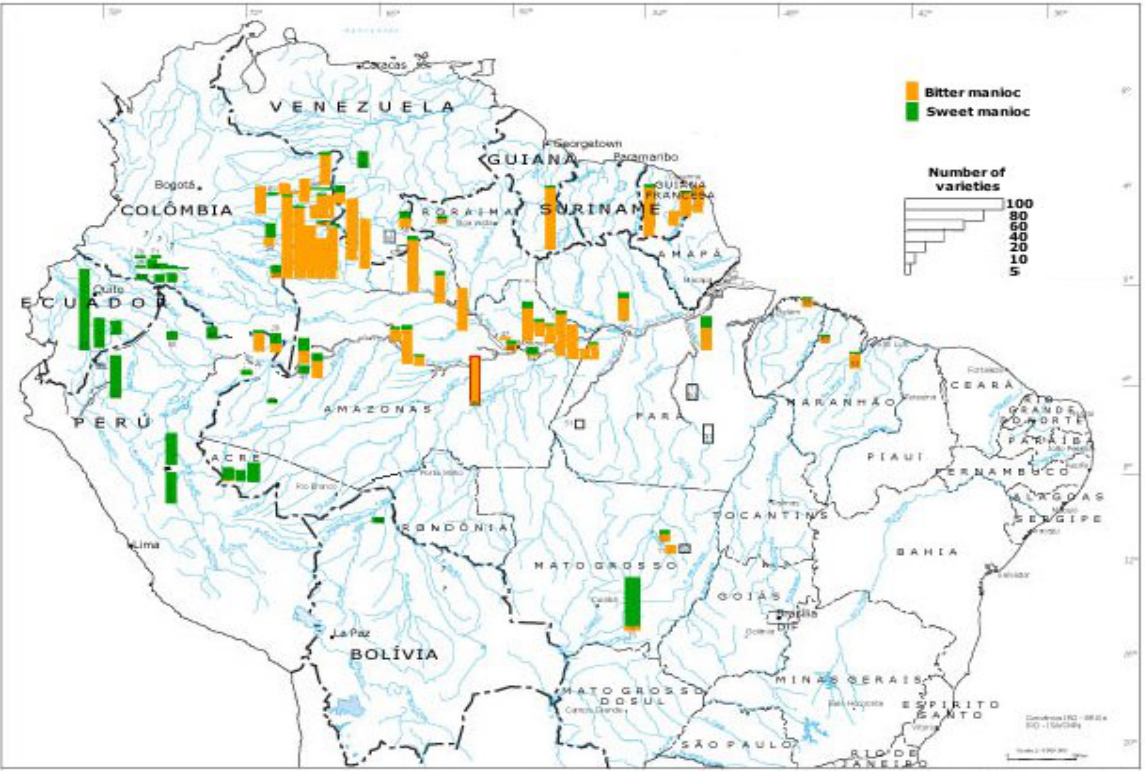
Figure 9. Map of bitter and sweet manioc varieties compiled from ethnographic sources by Emperaire [144], modified with permission. Bar with red outline in the middle Madeira River region reflects caboclo dataset presented by Fraser